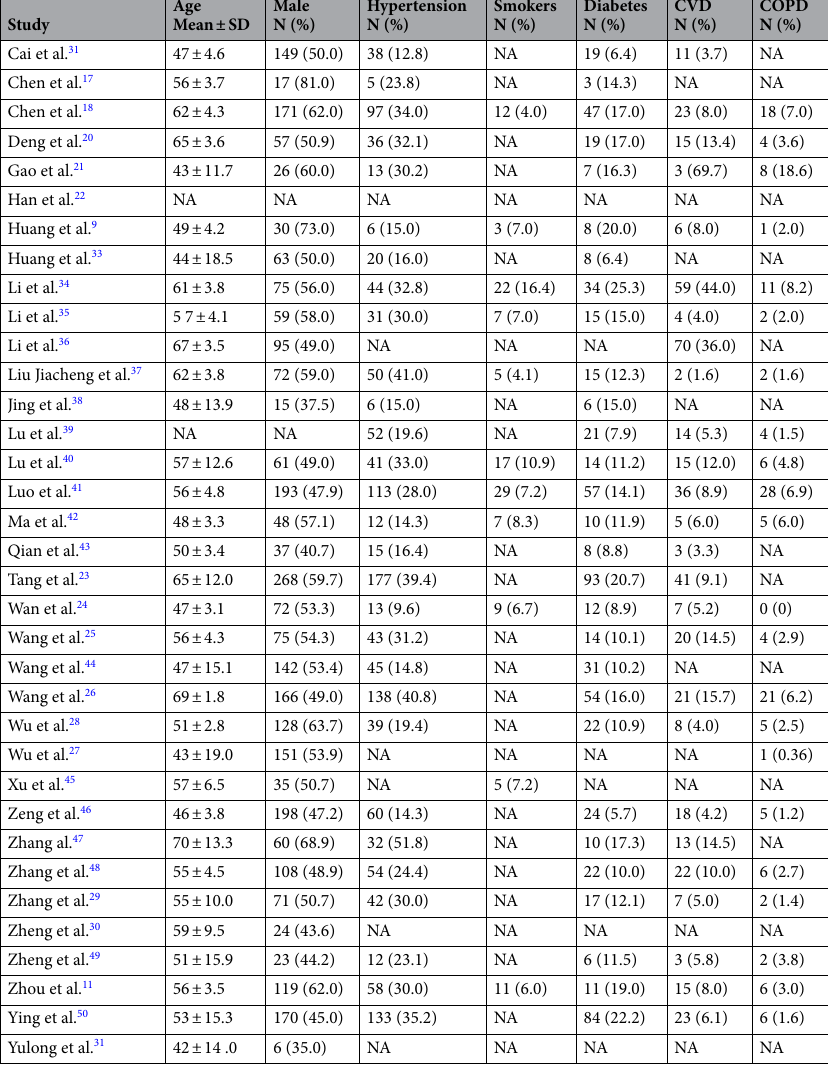
Table 2. Clinical characteristics of the patients included in the